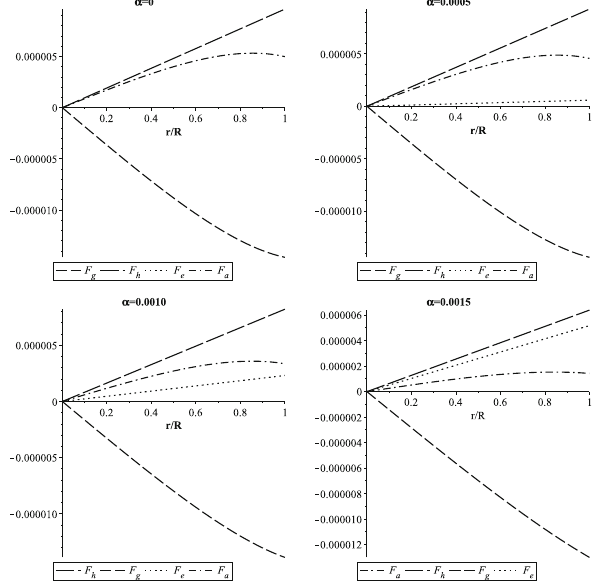
Fig. 9 Variation of the different forces as a function of the radial coor- dinate r / R for the strange stars LMC X − 4